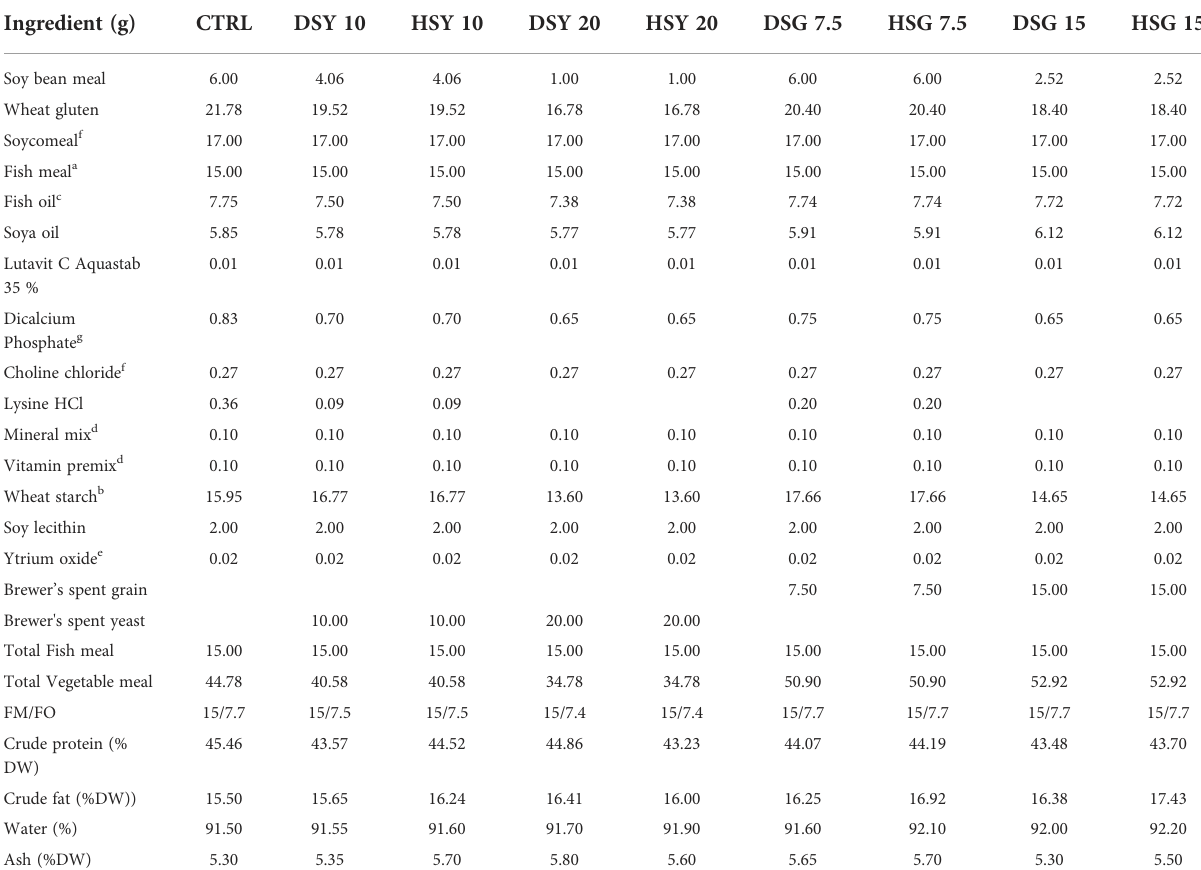
TABLE 1 Formulation of feeds used in the trial. Ingredient